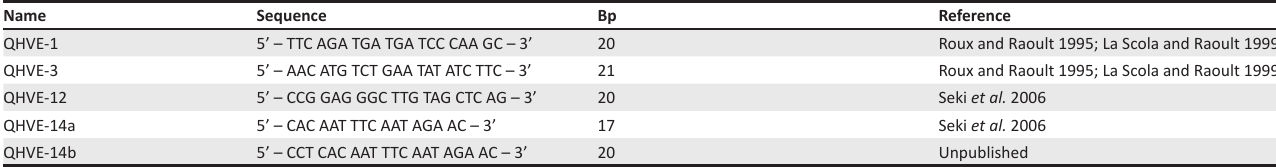
TABLE 1: Published genus-specific primers.